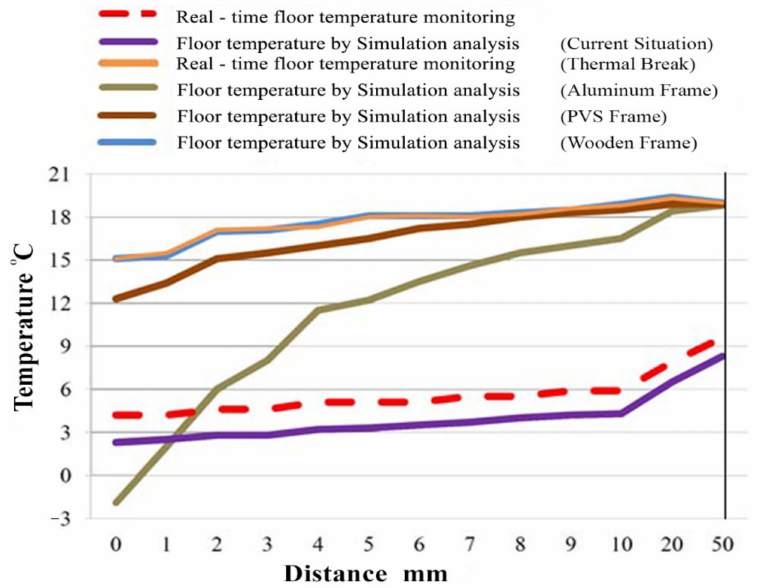
Figure 15. Floor temperatures for the first 50 mm using thermal break 50